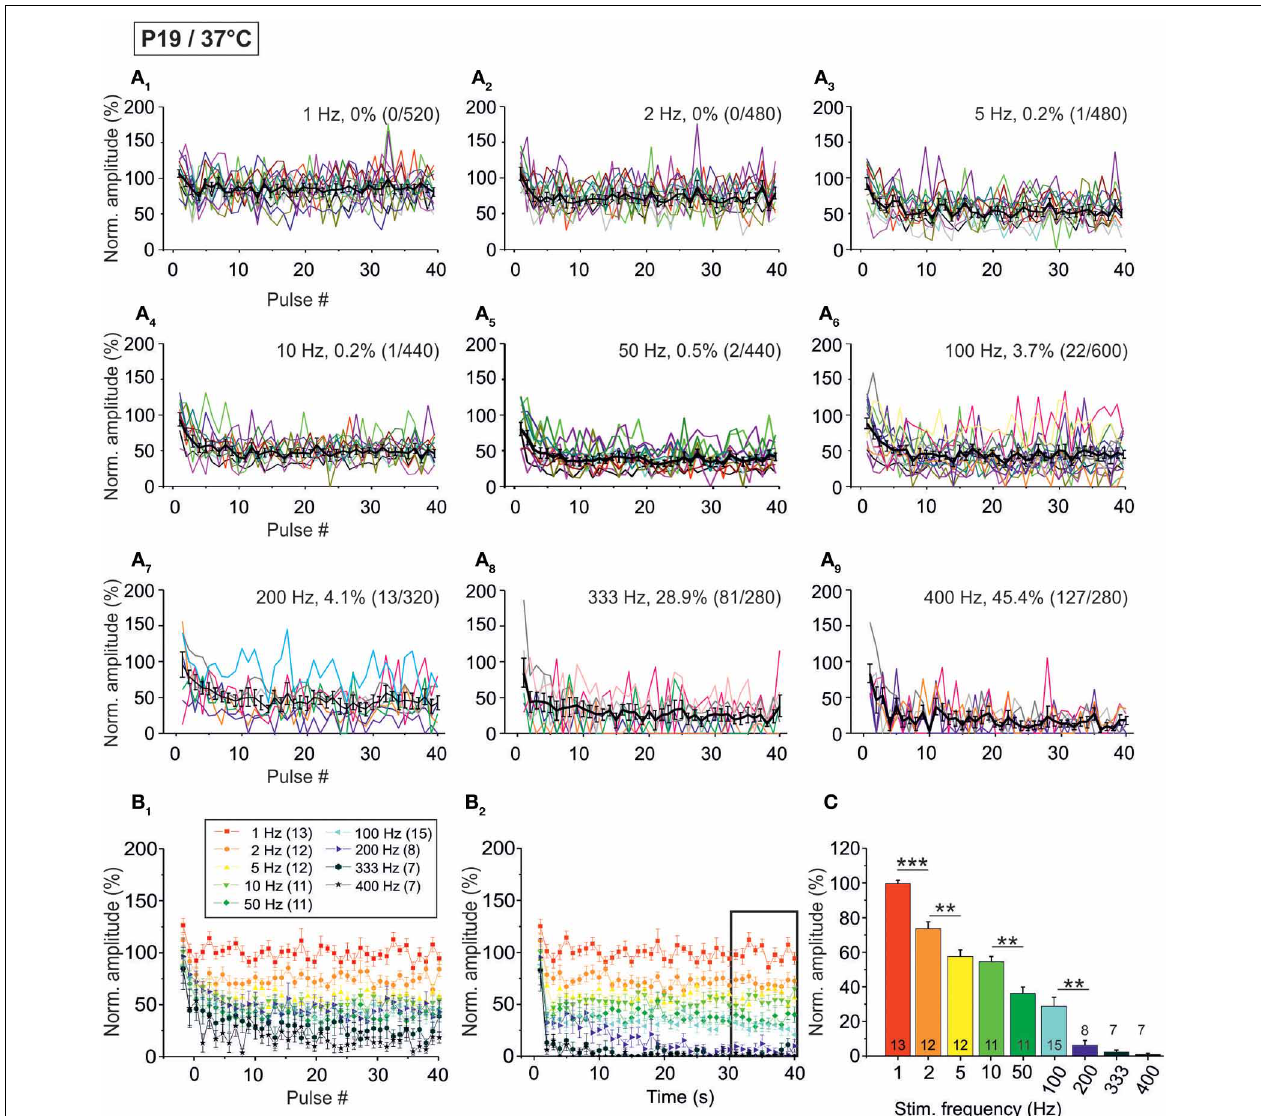
< 50% at frequencies ≥ 50Hz. (B 2 ) Mean values ± s.e.m. obtained during the complete40-s-periodsofstimulation(sampledat1-s-intervals).Colorcodeasin panel (B 1 ) .Noticethegradualdeclinewithfrequencyupto200Hz.Blackframe depicts the last 10 data points in each trace that underwent statistical analysis shown in panel (C) . (C) IPSC peak amplitudes decreased with increasing stimulation frequency, yet stayed at > 30% of the control amplitude up to 100Hz. N numbers in the inset of (B 1 ) correspond to all panels. ∗∗ p < 0 . 01; ∗∗∗ p < 0 .